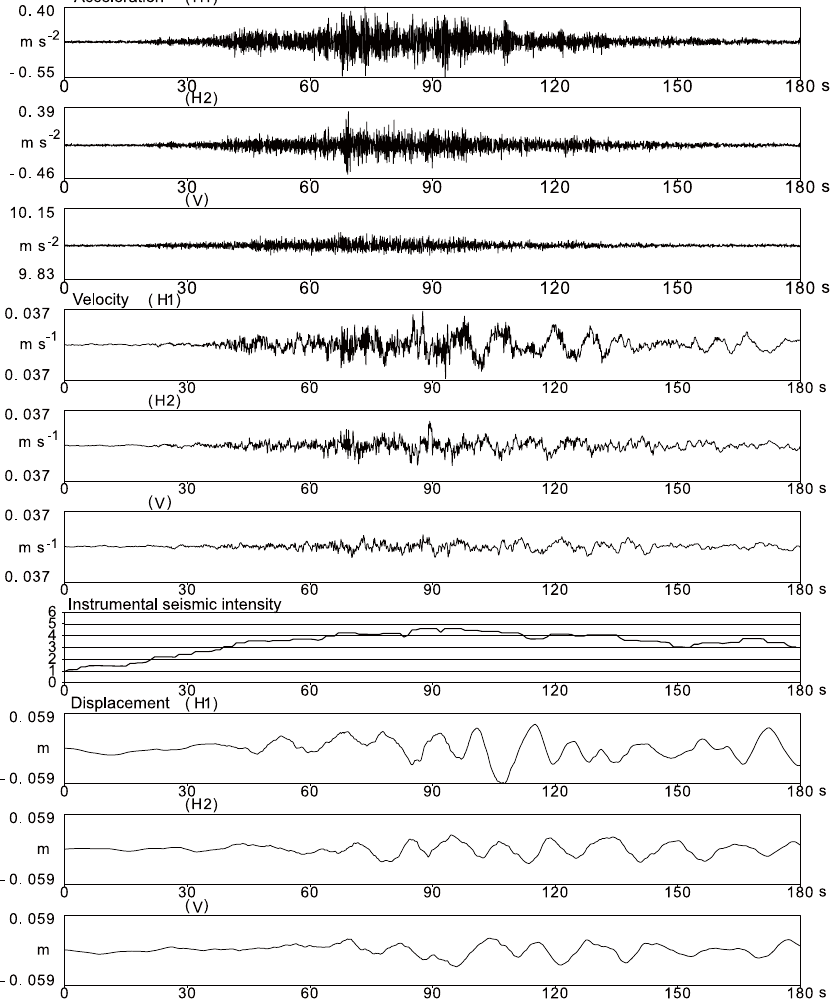
Figure 6. Seismic waves and instrumental seismic intensity obtained using prototype tsunami alarm equipment. Original acceleration records, velocity records for instrumental seismic intensity, instrumental seismic intensity, and displacement records are